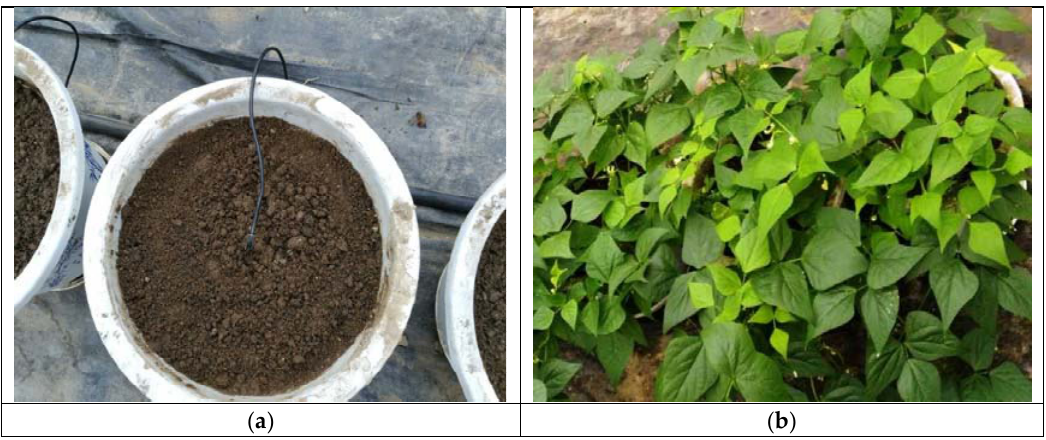
Figure 1. ( a ) Pots with drip irrigation, used for the experiment. ( b ) Green beans at the start of the flowering stage. Photos: Said Saleh, 2016.